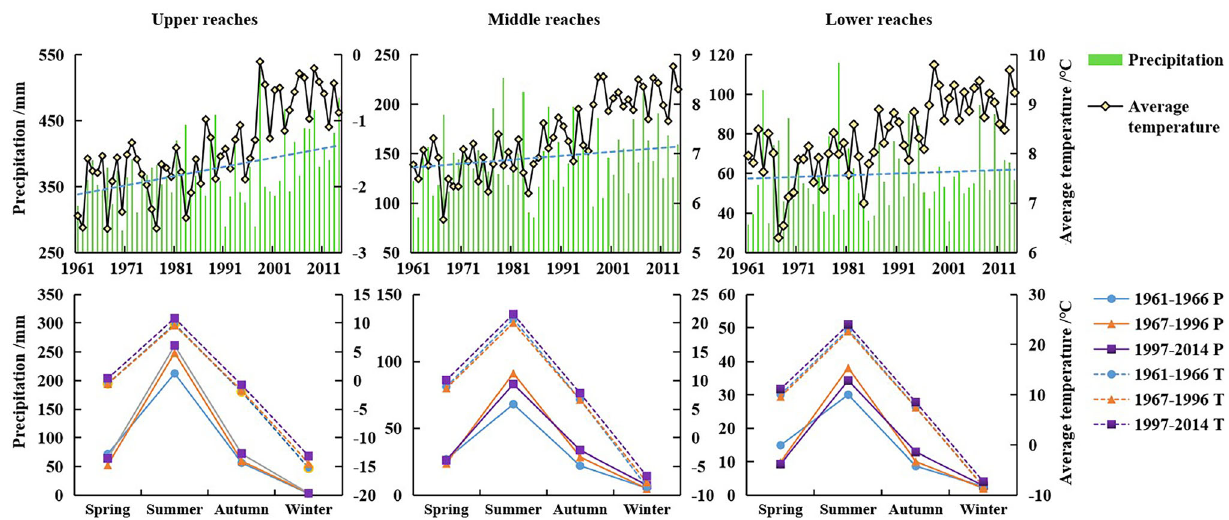
Fig. 10 Variation characteristics of precipitation and average temperature in the Heihe River Basin during